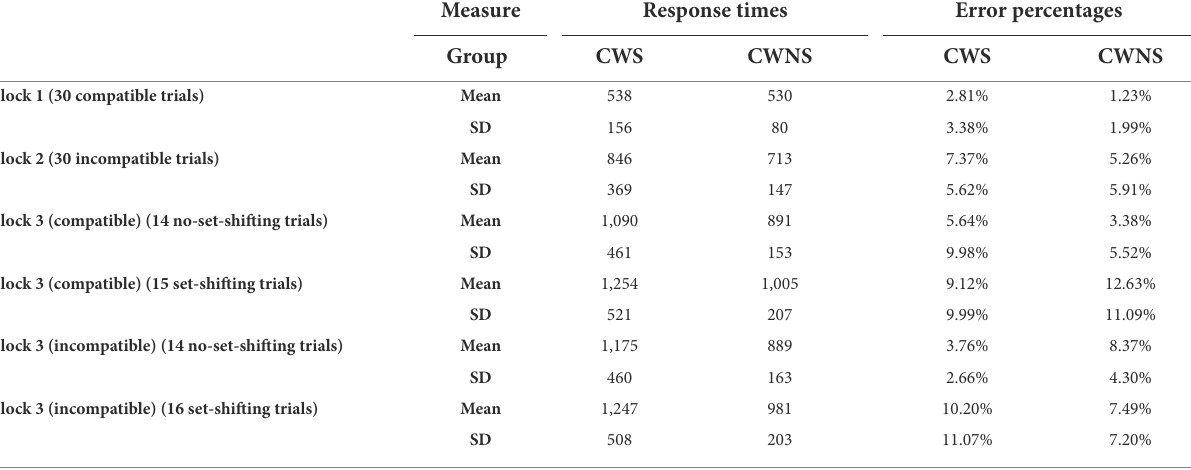
TABLE 3 Means and standard deviations for response times (in ms) and error percentages for each combination of the group and block factors for Block 1, Block 2, and Block 3 (compatible and incompatible parts with and without set-shifting) and for the two groups of